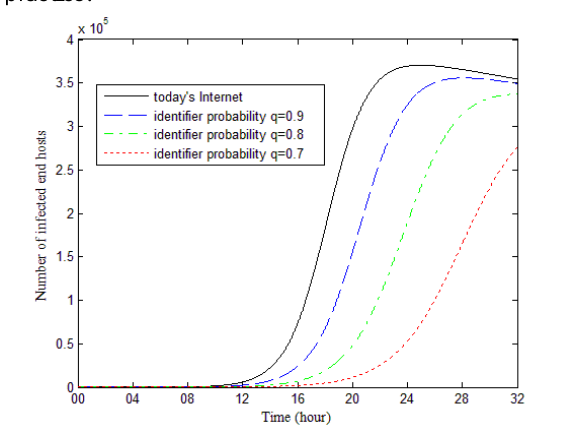
Fig. 3. Number of infected end hosts with different identifier